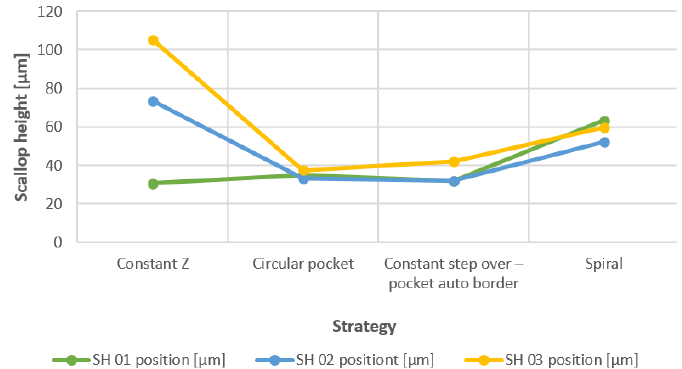
Figure 28. The comparison of scallop height in particular positions of measuring.